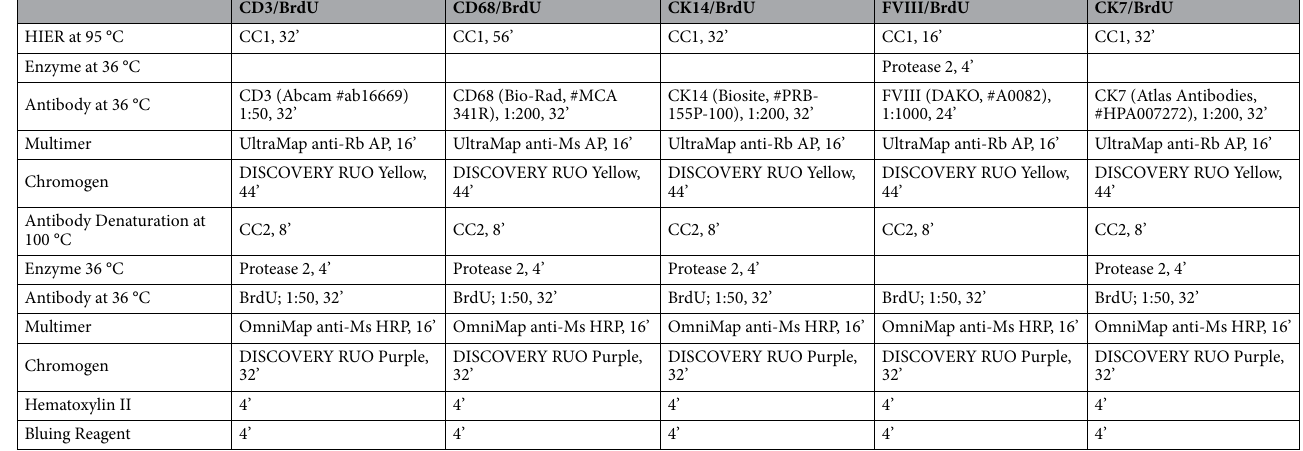
Table 1. Protocol parameters for DISCOVERY ULTRA chromogenic double-staining. Endogenous peroxidase was quenched with DISCOVERY Inhibitor. All antibodies were diluted in DISCOVERY ab